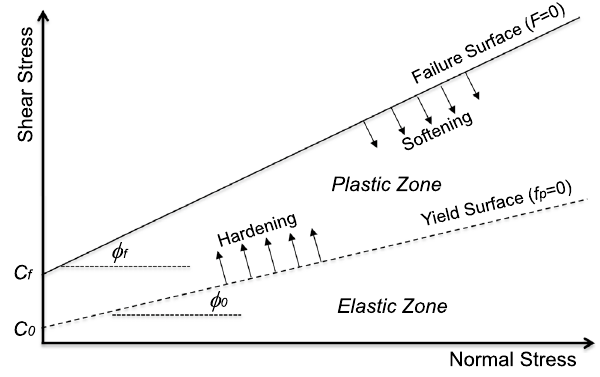
Fig. 2 Illustration of the yield and failure surfaces in the stress plane